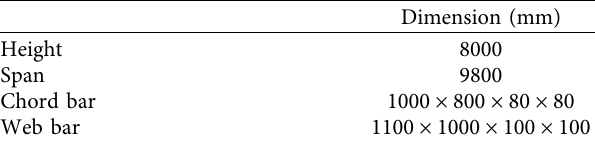
Table 6: Dimension of the prototype